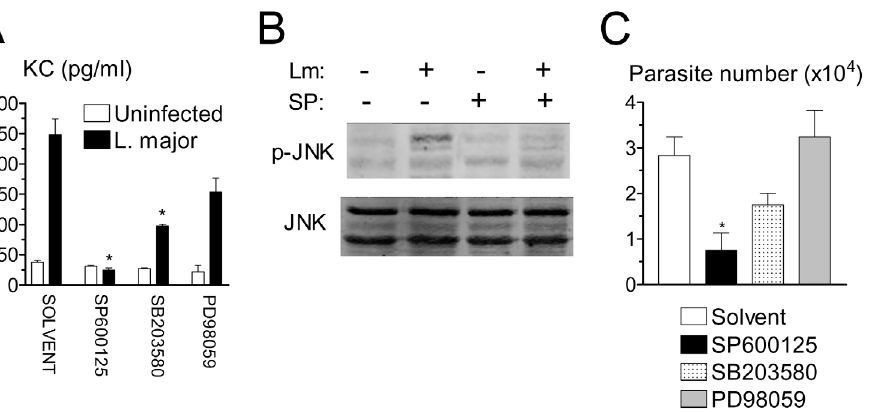
Figure 5. Effect of JNK inhibitor on release of KC, JNK activity and intramacrophagic parasite growth. (A) Resident macrophages were infected or not with L. major in the presence of solvent or the indicated MAPK inhibitors. The levels of KC were determined by ELISA after 20 h of infection. (B) Macrophages were infected or not in the presence of solvent or JNK inhibitor SP600125. After 4 h, the levels of JNK and p-JNK were determined by western blotting. (C) Macrophages were infected overnight and cultured for additional 3 d in the presence of solvent or MAPK inhibitors. Intracellular load of parasites was evaluated. Results are mean and SE of the number of extracellular promastigotes produced. * P , 0.05, compared to treatment with solvent.